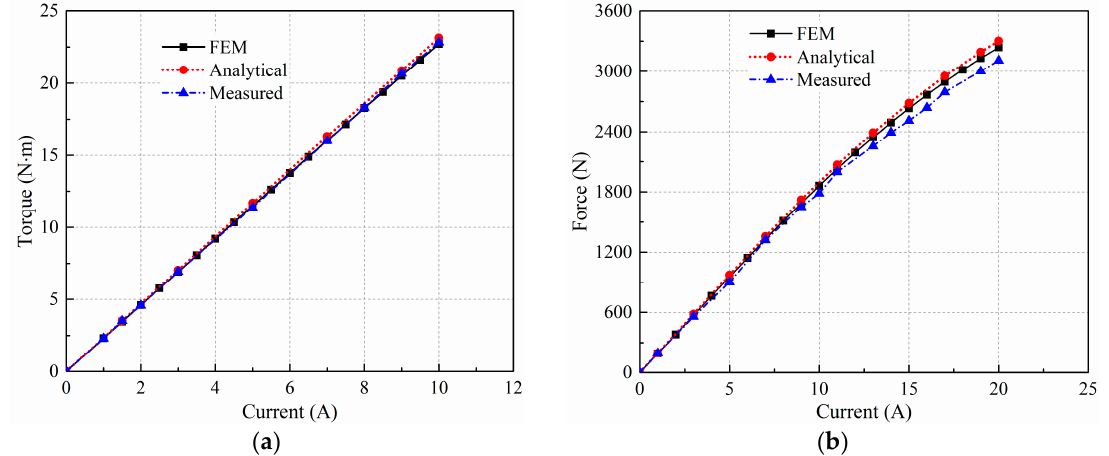
Figure 19. ( a ) Torque characteristics at rated speed; and ( b ) force characteristics at rated speed.